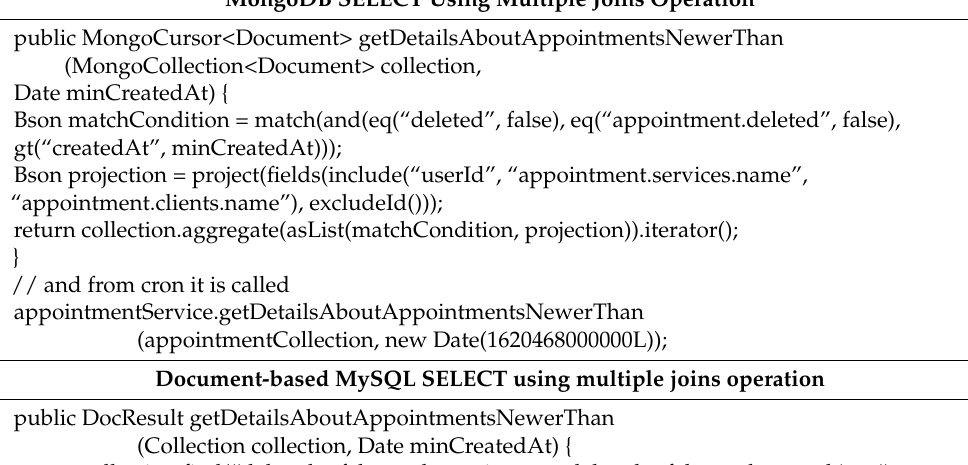
Table 8. Selection using a multiple joins operation. MongoDB SELECT Using Multiple Joins Operation